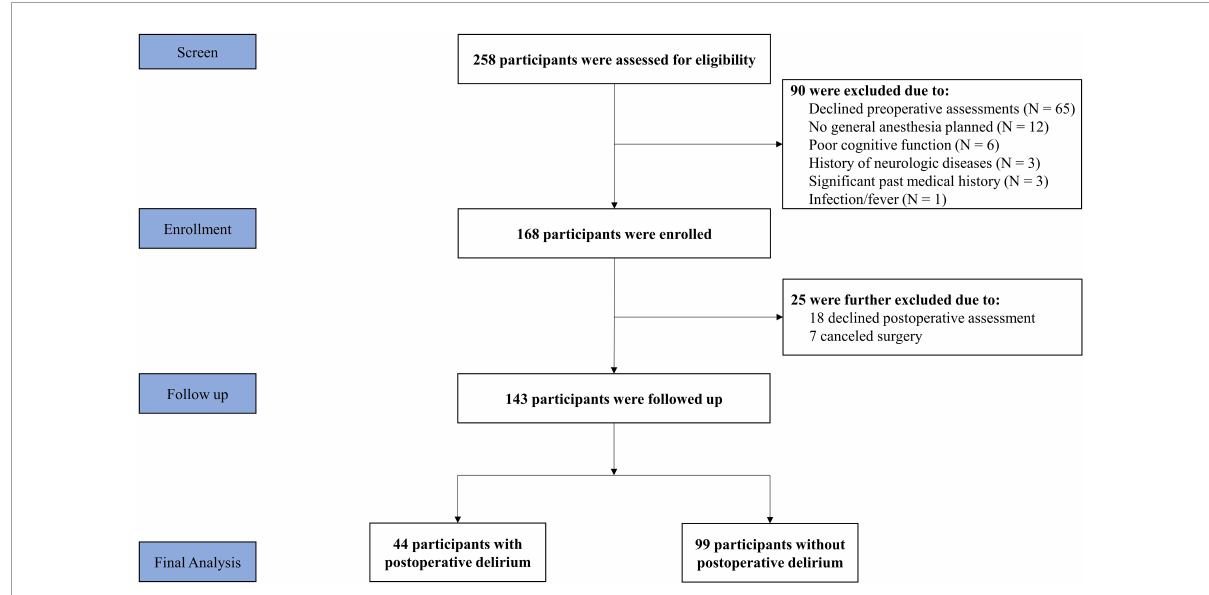
FIGURE1 Flow Diagram. Two hundred and fifty-eight participants were initially screened for the study. Ninety participants were excluded, resulting in 168 participants included at the enrolment of the study. During the follow-up assessment, another 25 participants were lost. Thus, a total of 143 participants were included in the final data